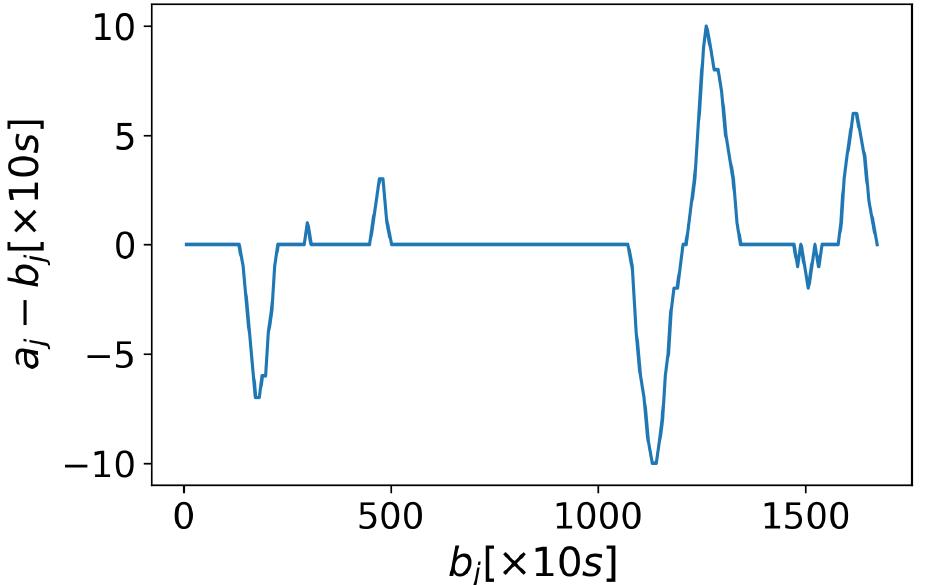
Figure 9. Adjustment of arrival time for each aircraft (Scenario 1).